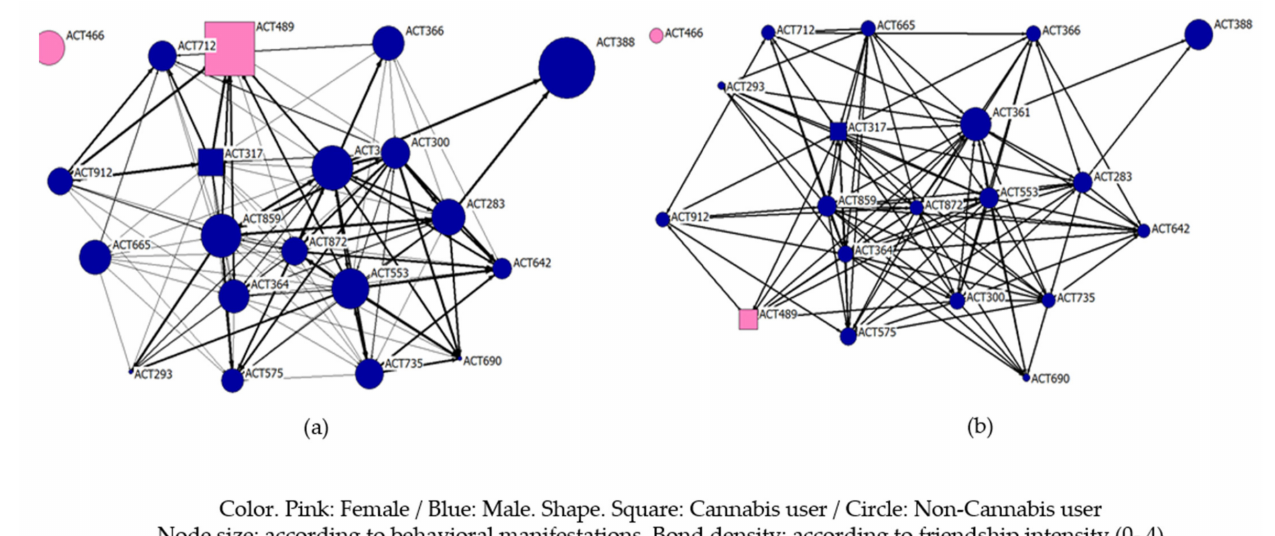
Figure 2. Friendship network structure and the study variables; ( a ) total of Student Stress Inventory–Stress Manifestations, ( b ) bbehavioral of Student Stress Inventory–Stress Manifestations.